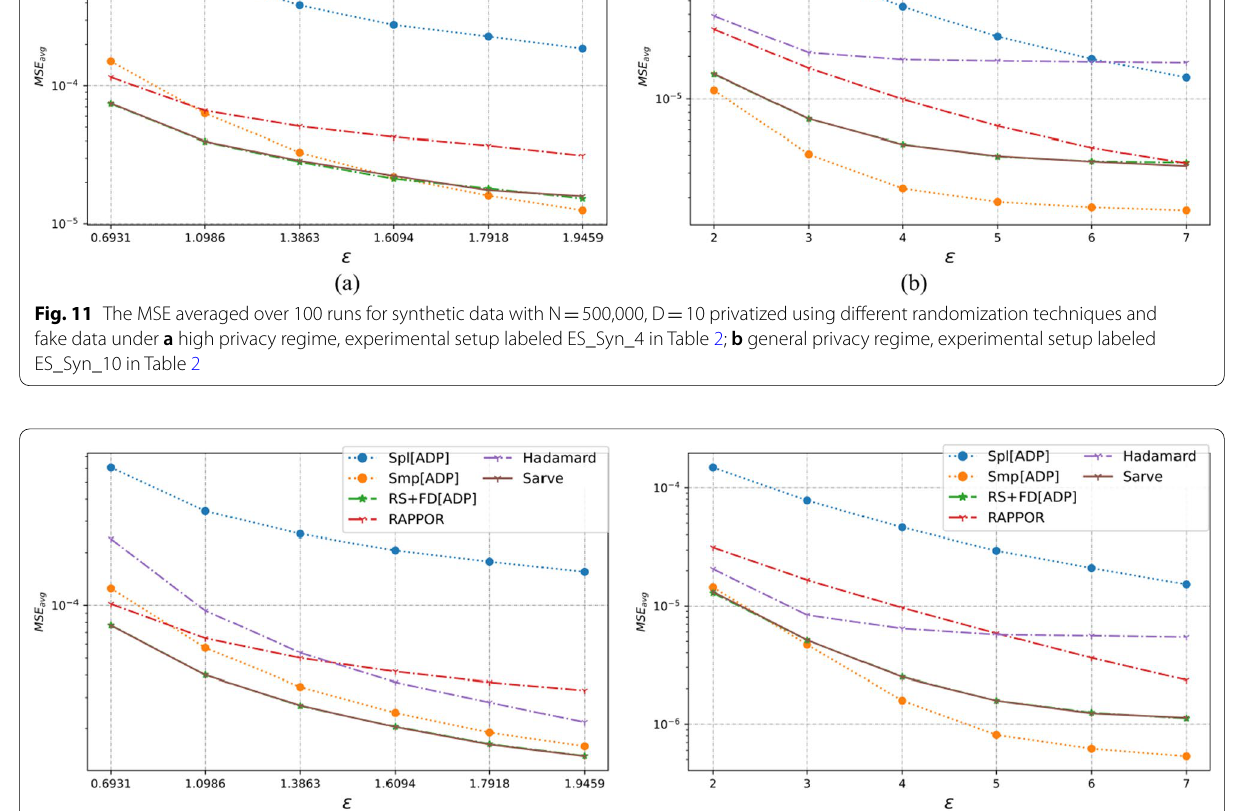
500,000, D 10 privatized using different randomization = =